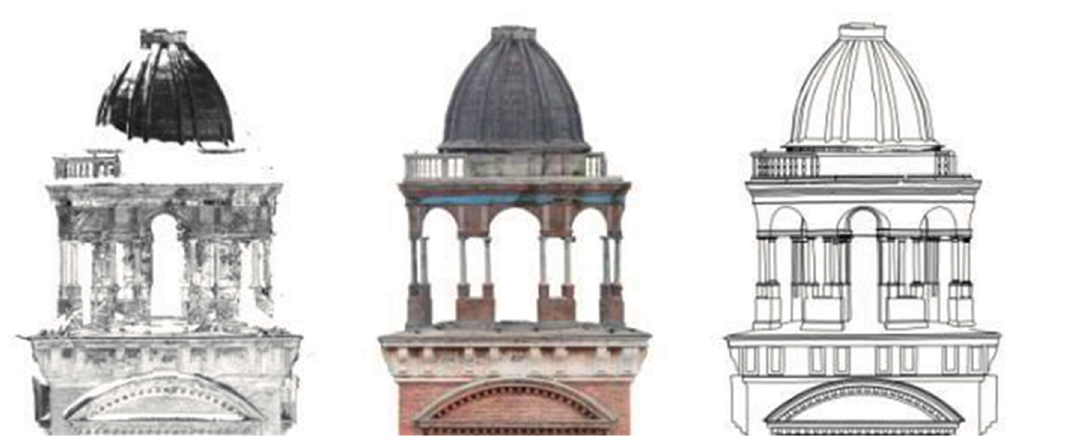
Figure 9. Comparison between the Santa Barbara bell tower’s top laser scanner data and the respective surface orthophoto elaborated from the photogrammetric 3D